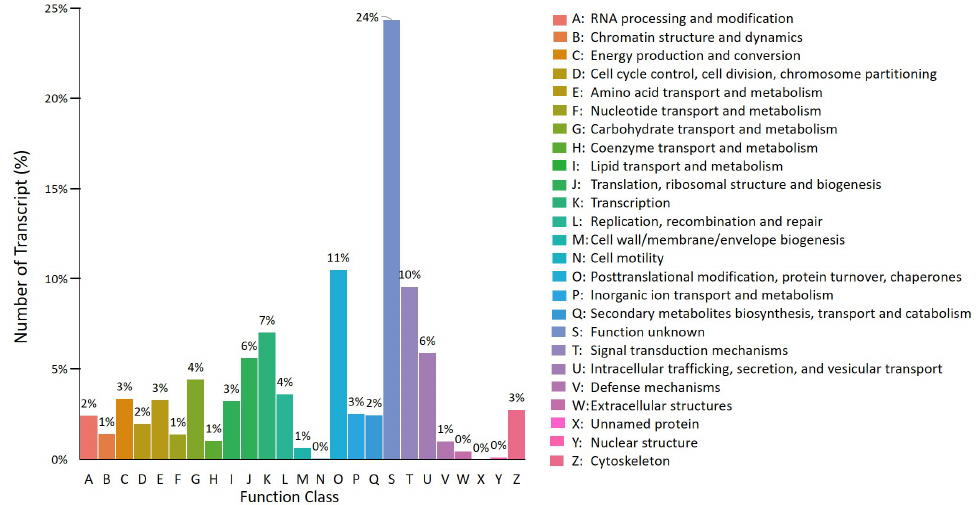
Figure 5. EuKaryotic Orthologous Groups (KOG) functional classification. The final transcriptome assembly was annotated against the KOG database to functionally classify the proteins into 25 functional groups.